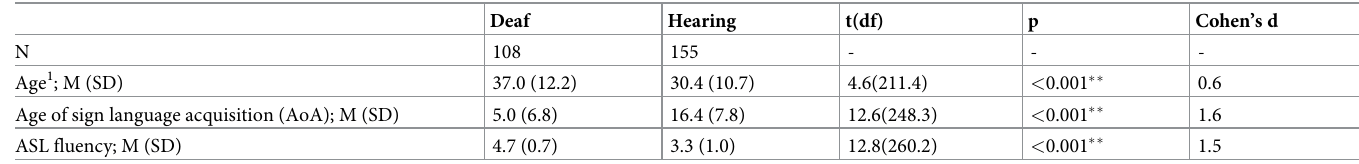
Table 2. Participants’ current age, age of sign language acquisition, and self-reported ASL fluency for two groups and statistical comparison between